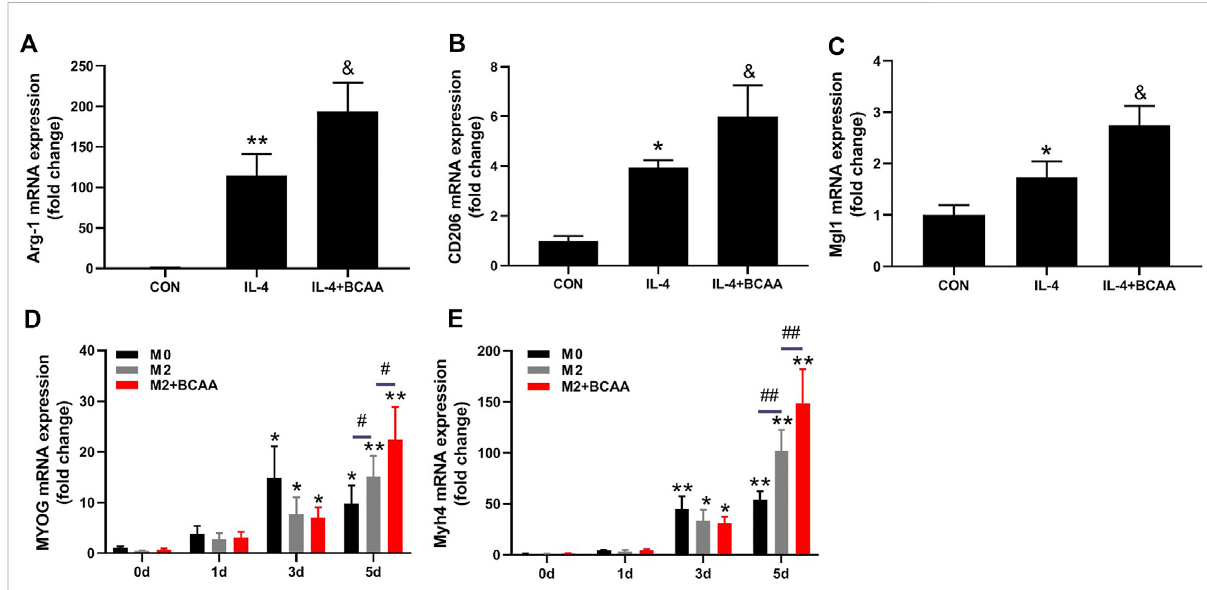
FIGURE 4 BCAA-promoted M2 macrophages enhance the differentiation of SCs. (A – C) The effect of BCAAs (800 μ m) on M2 polarization of macrophages. (D,E) The effect of BCAA (800 μ m)-treated M2 macrophages on C2C12 differentiation. Data are presented as mean ± SEM. * p < 0.05, ** p < 0.01 vs. CON/0d; & p < 0.05, && p < 0.01 vs. IL-4; # p < 0.05, ## p < 0.01 between groups at the same time